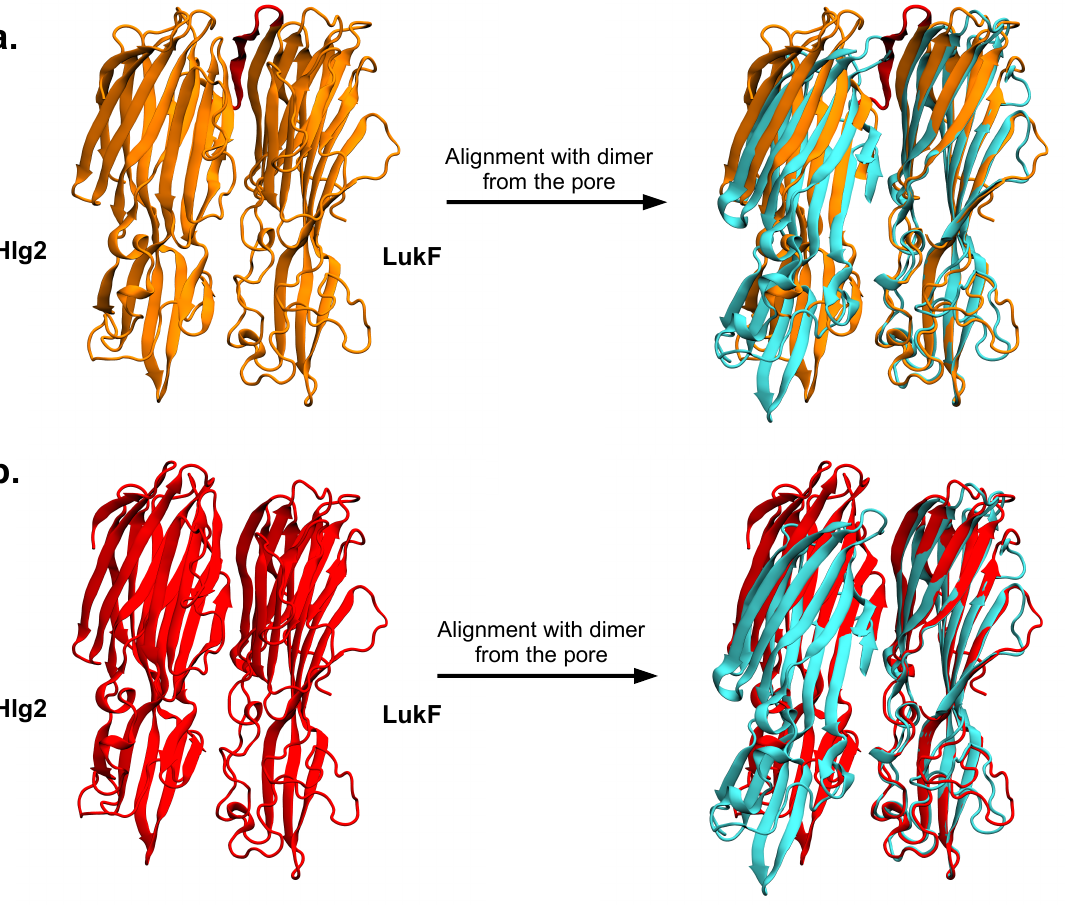
Figure 6. Graphical representations of the HADDOCK models of the Hlg2-LukF dimer in the presence ( a ) or in the absence ( b ) of the LukF amino-latch. The comparison with the two adjacent protomers in the final pore (colored in cyan) is performed after structural alignment on LukF alone. In the comparison with the pore dimer, the stem/prestem domains are not shown for